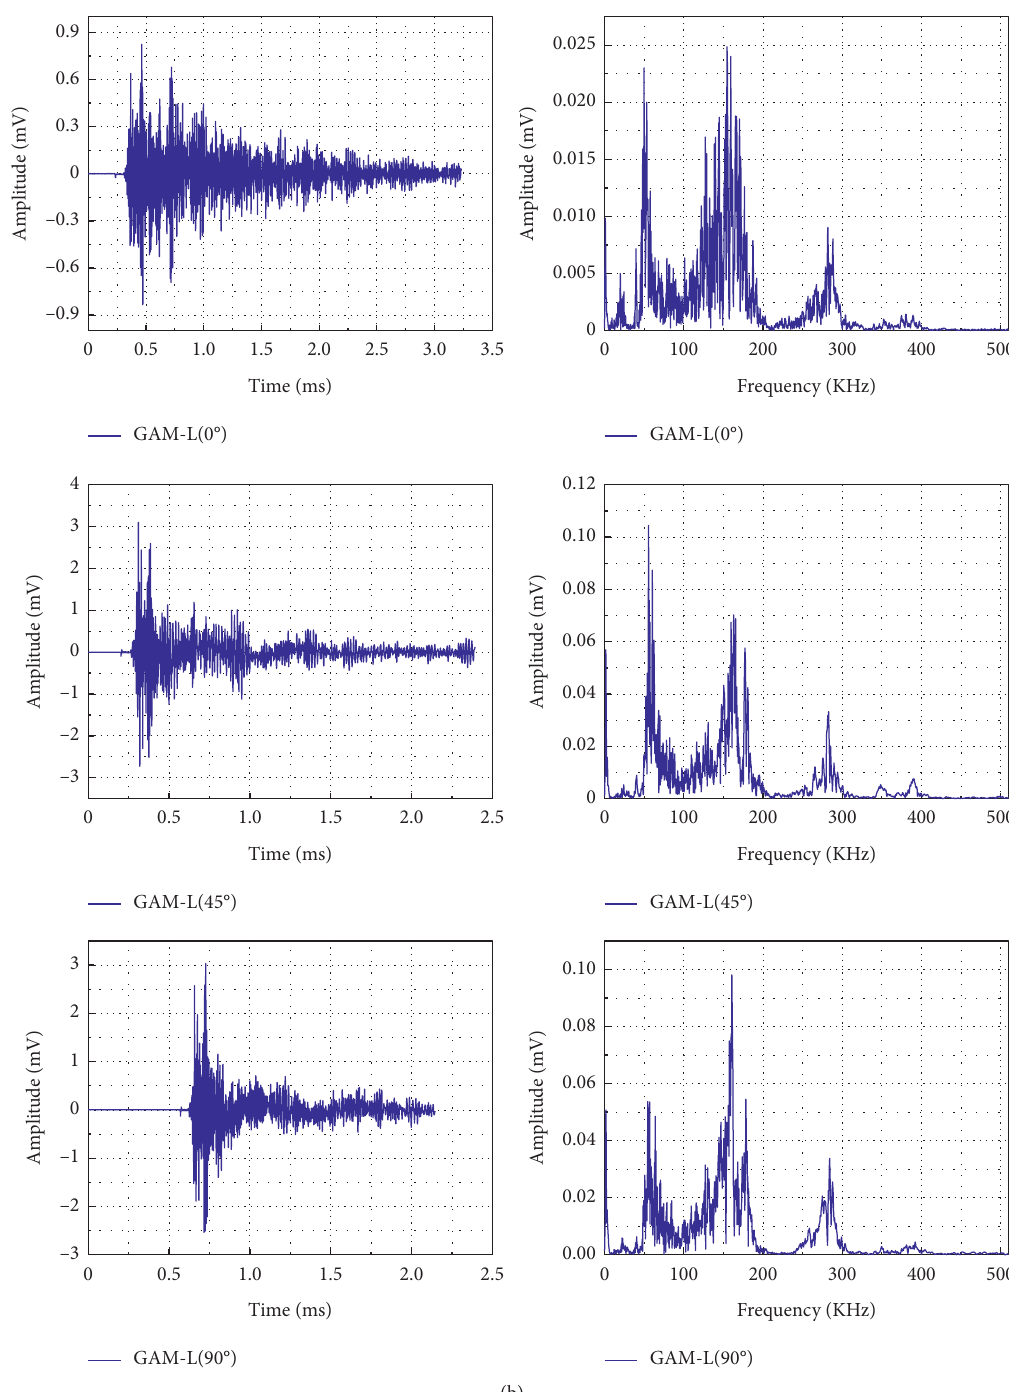
Figure 9: The time waveform and spectrogram of measuring point M2 of pate-shaped